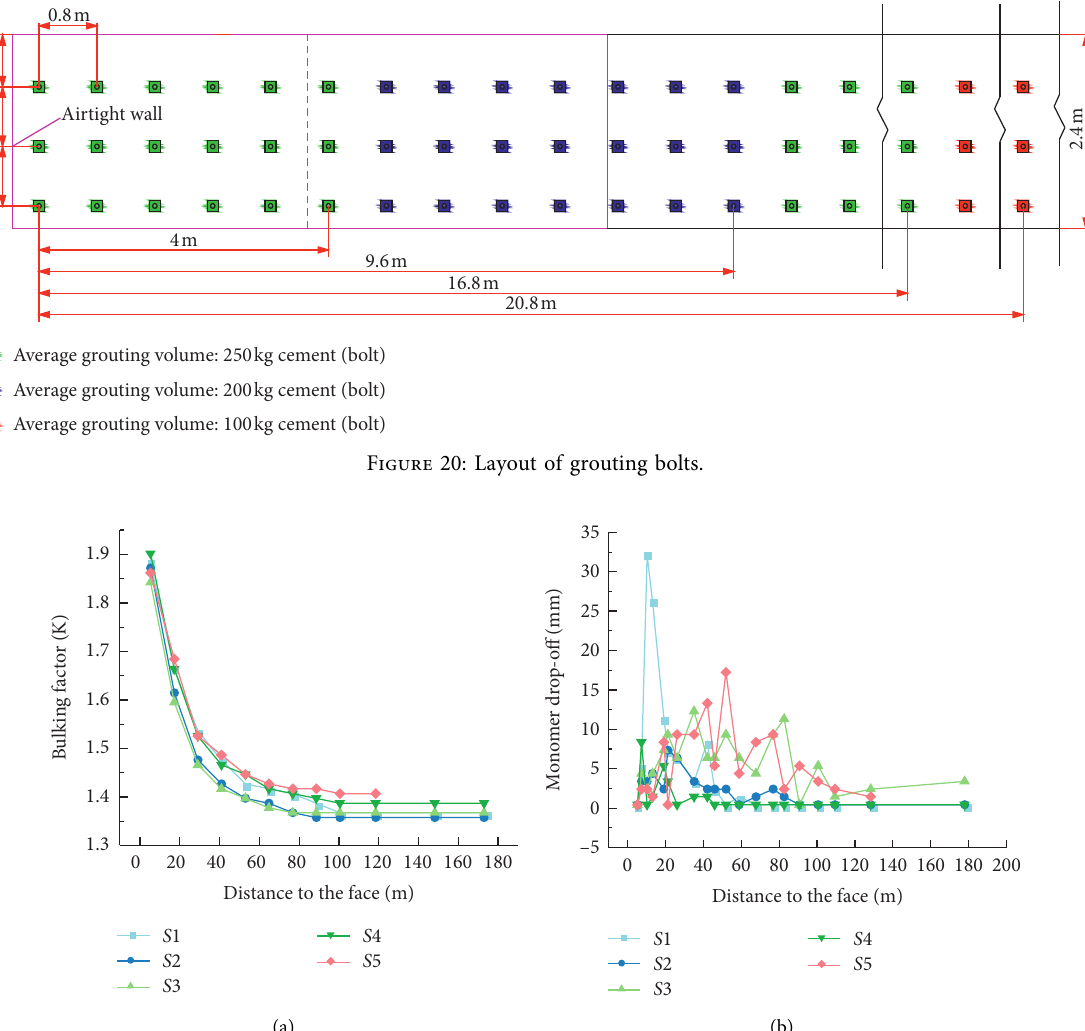
Figure 21: Bulking factors and monomer drop-offs during the mine face’s advance. (a) Bulking faction. (b) Monomer